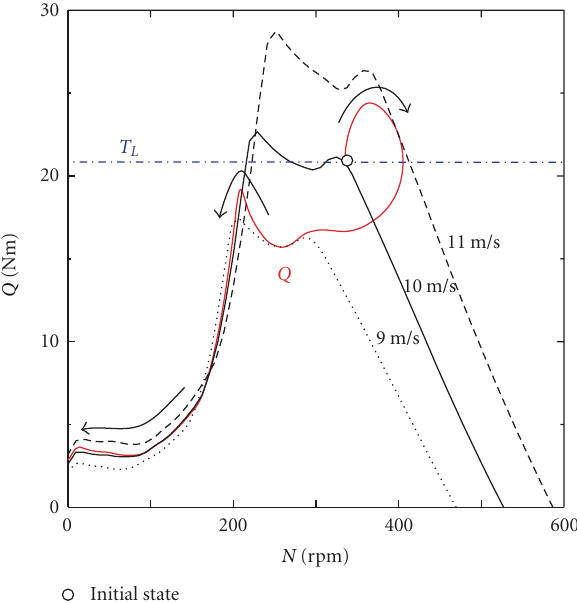
Figure 27: Locus of torque, Q , of pulsating wind in the case where V = 10 m/s, T = 32 s, and I = 3kgm 2 . Constant load torque is T L = 0